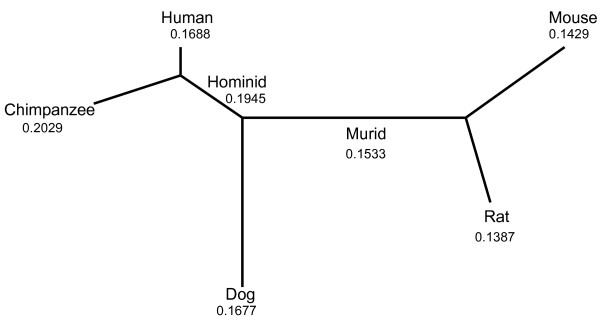
Five species tree with branch-specific ω ratios. The median ω value from free-ratio model estimates of evolutionary rates in 3079 genes for humans, chimpanzees, mouse, rat and dog.